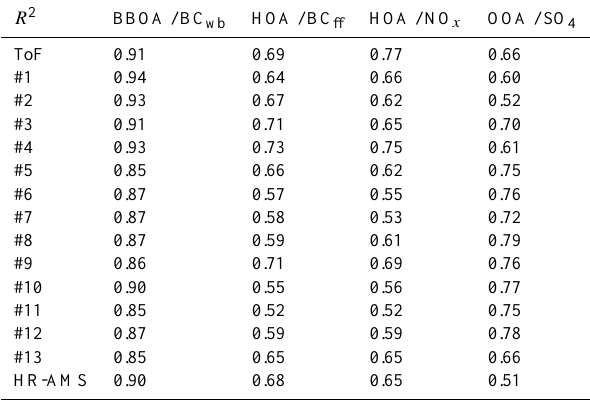
Table 1. Coefficients of determination ( R 2 ) between the factors of each instrument’s best ME-2 solution (left column of Table 2) and external measurements. R